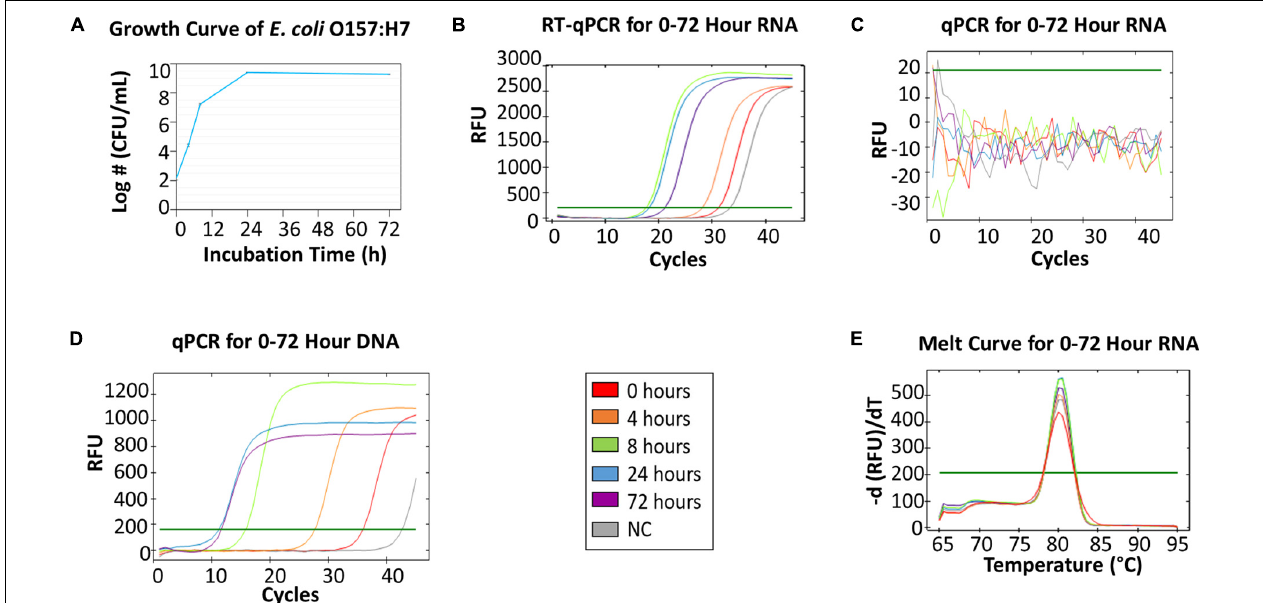
FIGURE 2 | RT-qPCR and qPCR of E. coli O157:H7 from 0, 4, 8, 24, and 72 h growth in BHI. (A) The growth curve of E. coli O157:H7 at 0, 4, 8, 24, 72 h in BHI. The initial concentration was 3-log CFU/mL. (B) RT-qPCR for RNA collected from five time points. (C) qPCR for 0–72 h RNA as the negative control (NC) for DNA contamination – no DNA contamination was found in those samples. (D) qPCR for DNA collected from five time points. (E) The melting curve analysis of RT-qPCR for 0–72 h RNA.